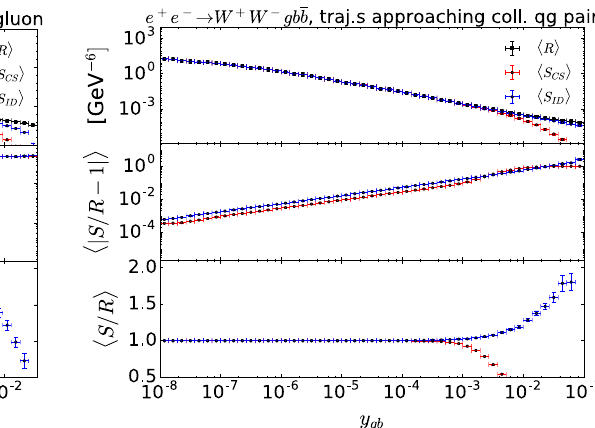
Fig. 7 Matrix elements R = | M R | 2 and sum of associated dipoles (cid:21) D (standard CS-dipoles in red, pseudo-dipoles in blue) for the S = process e + e − → W + W − gb ¯ b . Both dipole-types are evaluated on the